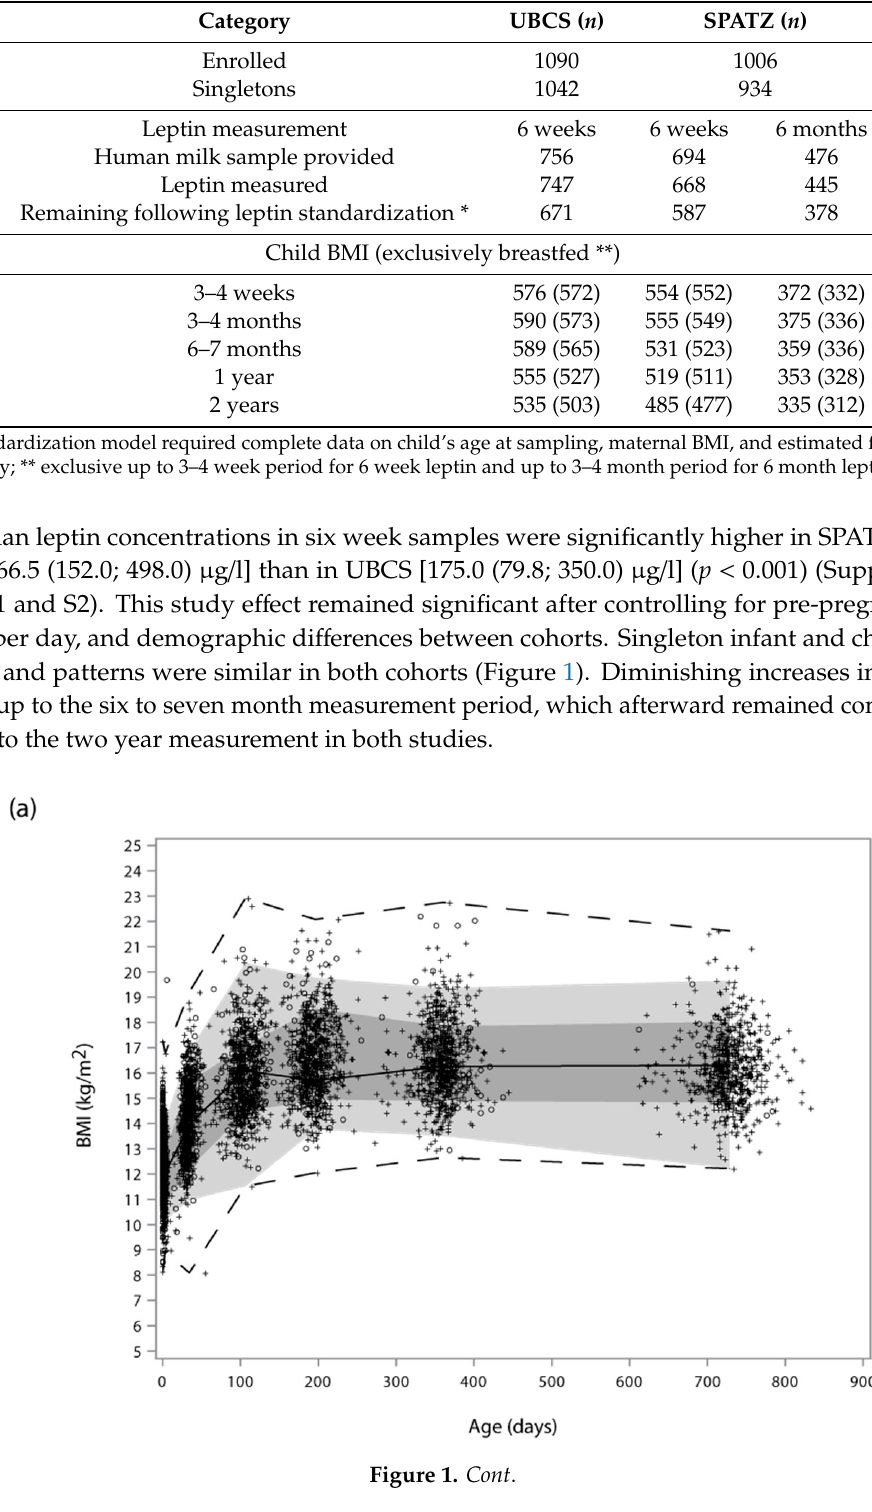
Figure 1. Functional boxplot of child body mass index (BMI) across ages at measure overlaid with scatter plots at each age in the SPATZ ( a ) and UBCS ( b ) cohorts. Scatter plots represent children with complete (+) BMI data used to calculate the functional boxplot and children with incomplete (O) data at one or more measurement periods. (Measurement periods were each collapsed to the average measurement period time for functional boxplot calculation, which is why the functional boxplots exhibit kinks at the center age of each scatter and end at the center age (approximately 750 days) of the last measurement. The solid black line represents the median curve of the functional boxplot. The dark and light grey bands are the central 10% and 50% regions, respectively; the latter corresponding to the interquartile range in a usual boxplot. The dashed lines indicate the nonoutlying envelopes determined by the 1.5 times the 50% central region rule (like the whiskers in a usual boxplot), which in both images correspond to the minimum and maximum since no outliers were detected.).